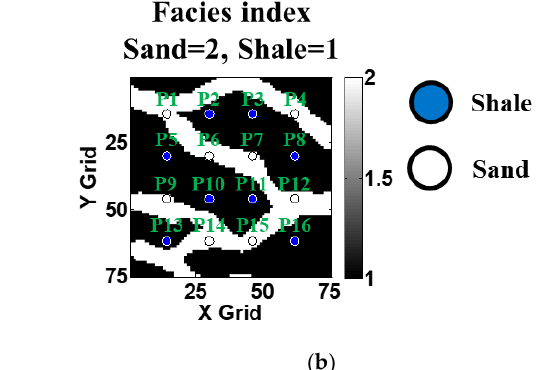
Figure 7. Training image for SNESim and the reference field.